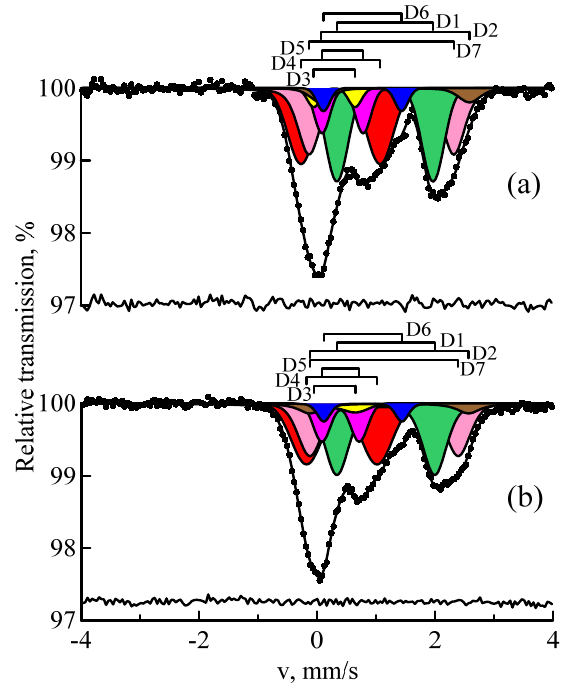
Figure 4. MS spectra of 57 Fe nuclei in the samples of the non-magnetic fraction of fly ashes FA1 ( a ) and FA2 ( b ). Table 3. Hyperfine parameters of the non-magnetic fraction of the fly ashes FA1 and FA2.